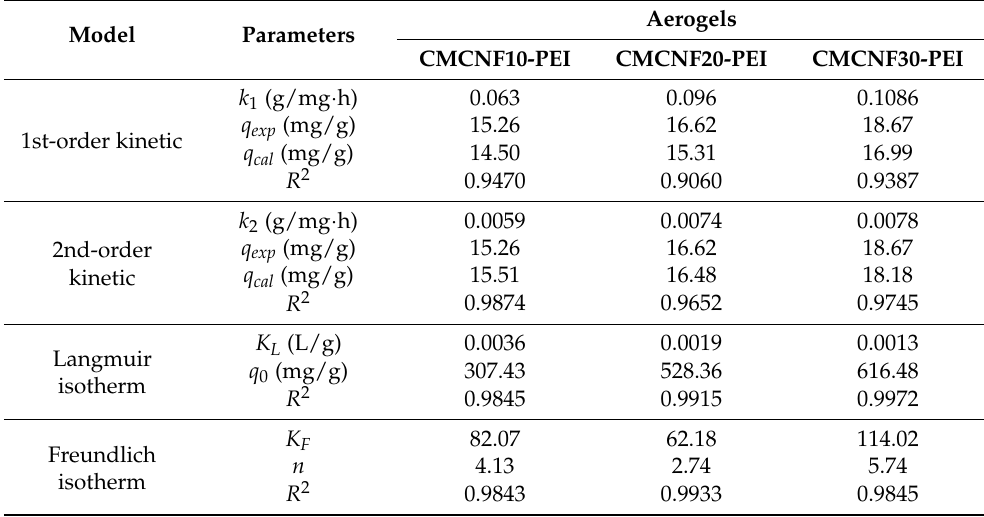
Table 3. Kinetic and isotherm parameters for Cu 2+ adsorption onto CMCNFs-PEI